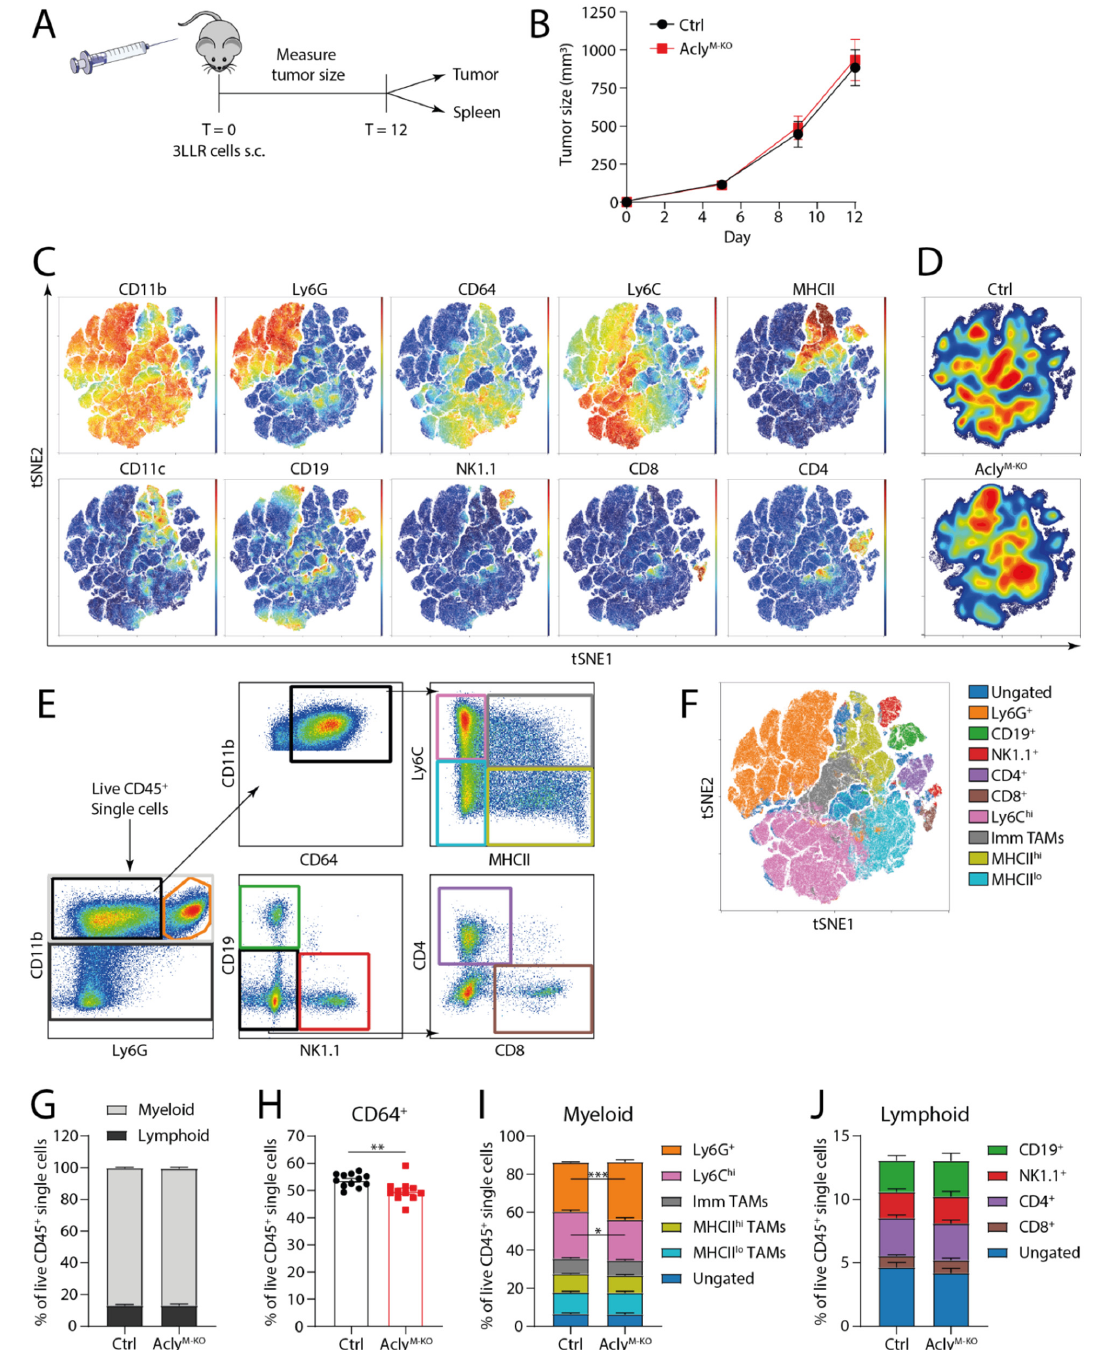
Figure 3. Acly M-KO macrophages do not improve in vivo anti-tumor responses in a 3LLR tumor model. ( A ) 3LLR lewis lung carcinomas were subcutaneously grown for 12 days. ( B ) Growth curves of 3LLR tumors for Acly fl/fl and Acly M-KO mice. ( C ) Unsupervised clustering analysis of live CD45 + single cells isolated from 3LLR tumors. ( D ) Density distribution for control and Acly M-KO mice over the unsupervised clustering. ( E ) Manual gating strategy of different immune cell populations. ( F ) Overlay of manually gated populations from ( E ) on unsupervised clustering in ( C ). ( G ) Percentages of CD11b + or CD11b − cells of live CD45 + single cells. ( H ) Percentage of CD64 + of live CD45 + single cells. ( I ) Percentages of myeloid or ( J ) lymphoid cell populations live CD45 + single cells. For F–J, colors match the colors used for manual gating in ( E ). p -values are indicated as <0.05 *, <0.01 **, <0.001 ***. Results are shown as mean ±